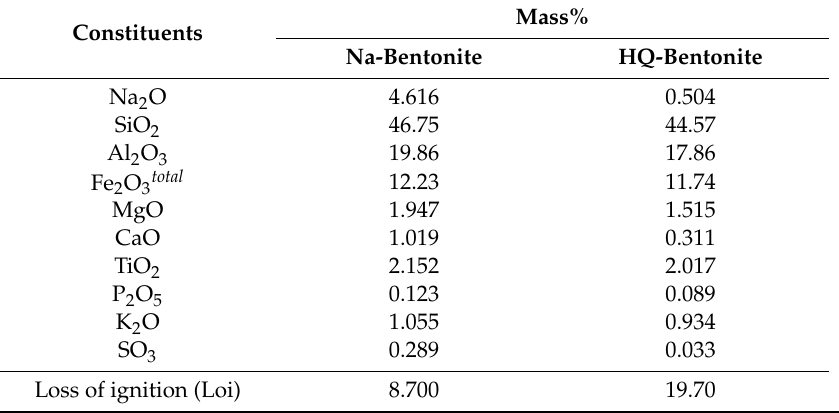
Table 1. The chemical constituents of Na-bentonite and HQ-bentonite.